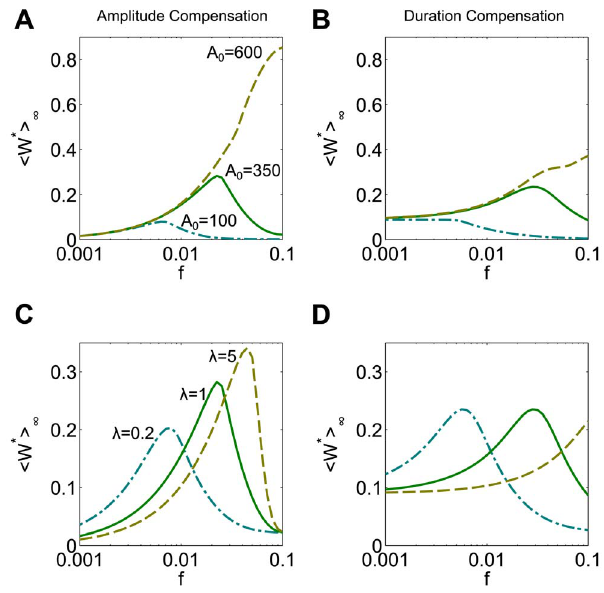
Figure 10. Matching input signal characteristics to the sigmoidal nonlinearity and system kinetics in the Goldbeter- Koshland model. ( A ) Amplitude compensated signals with a sufficiently large A 0 lead to a monotonic increasing response (tan dashed curve), while signals with smaller A 0 elicit bell-shaped responses (green solid curve, teal dash-dotted curve). ( B ) Duration compensated signals with the same A 0 as in (A) elicit monotonic increasing (tan, A 0 =600), bell-shaped (green, A 0 =350), or monotonic decreasing (teal, A 0 =100) responses. For each A 0 used, d 0 =10 at frequency f 0 =0.01. ( C ) Multiplying all rate constants by a factor l shifts the location of the peak response to amplitude compensated input signals (A 0 =350) relative to the default system (green solid curve, l =1). Slower kinetics lead to a left-shifted response curve, while faster kinetics lead to a right shifted curve with a peak that remains in the frequency range tested. ( D ) For duration compensated signals, a system with slower kinetics (teal dash-dotted curve, l =0.2) has a left shifted peak, while fast kinetics (tan dashed curve, l =5) may shift the peak beyond the frequency tested. Note that the , W * . ‘ values have been normalized by dividing by W T . A 0 =350 and d 0 =10 at frequency f 0 =0.01.